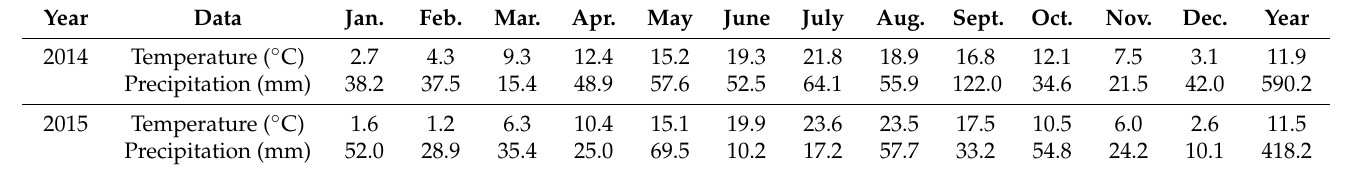
Table 2. Meteorological data (average temperature ( ◦ C) and total precipitation (mm) in individual months) for the location Nitra, Slovakia, for the year 2014 and 2015.